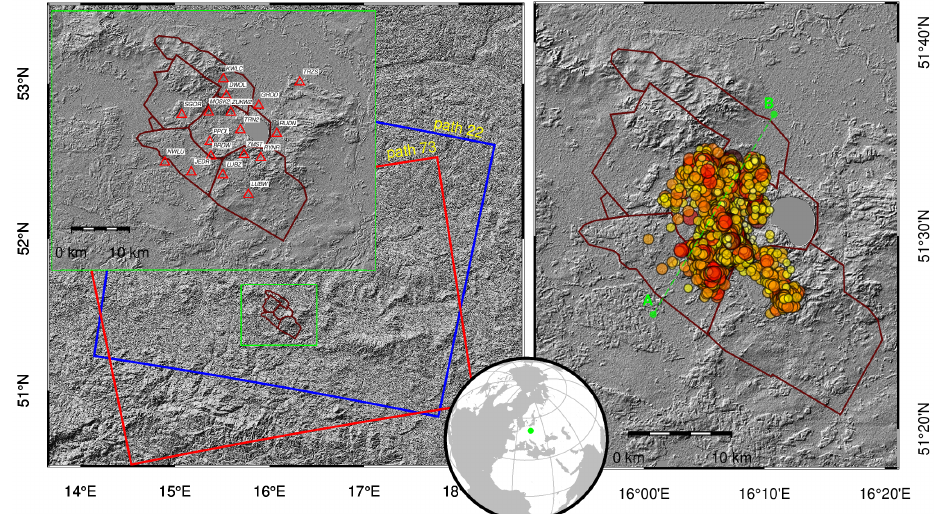
Figure 5. Ground coverage of the Sentinel 1A/B acquisitions for the Legnica-Glogow Copper Belt area and the location of the seismic network stations (left). On the right: location of over 6000 mining tremors ( M W between 0.9 and 4.0) recorded in the period from 10 December 2013 to 31 August 2020 (source: IS EPOS (2017), episode: LGCD, https://tcs.ah-epos.eu/#episode:LGCD (accessed on 9 November 2020), doi:10.25171/InstGeoph_PAS_ISEPOS-2017-006). The dashed green line represents the cross-section of the profile shown in Figure 6.